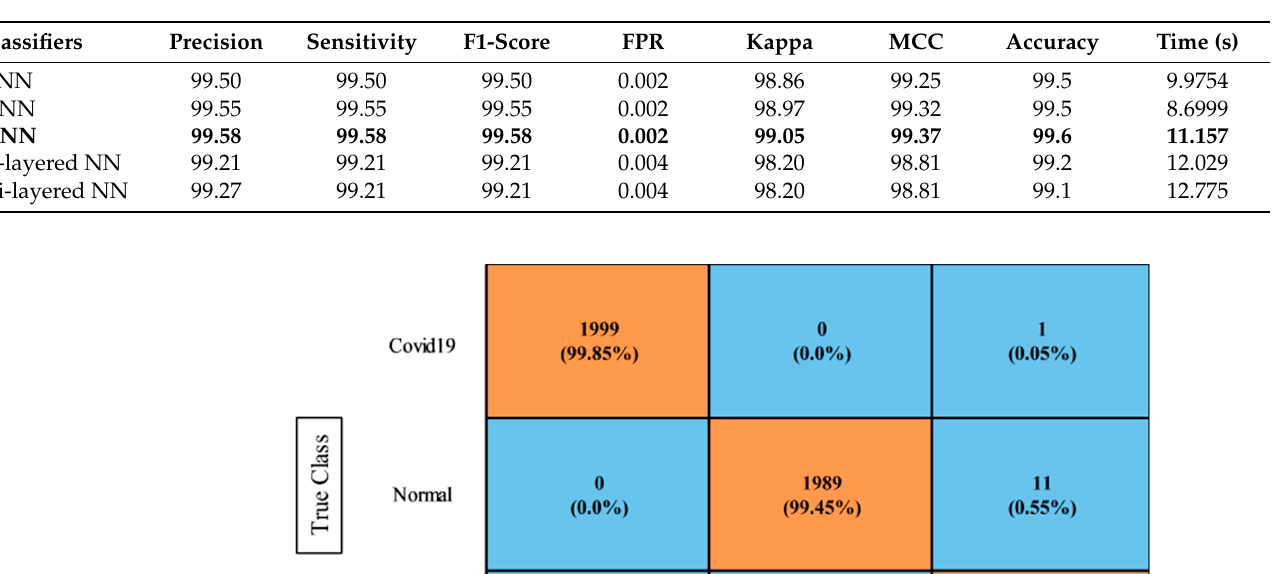
Table 4. Proposed improved TGO optimization results on Chest X-ray dataset.